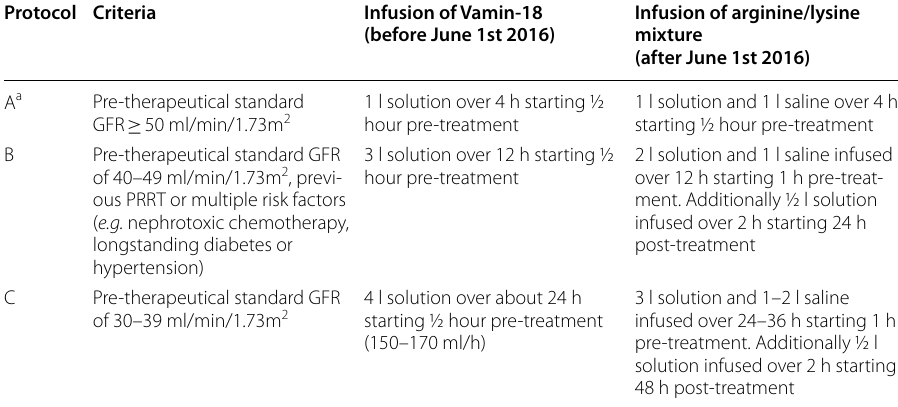
a Infusion of the arginine/lysine mixture in Protocol A corresponds to the EANM guidelines recommendations [3]